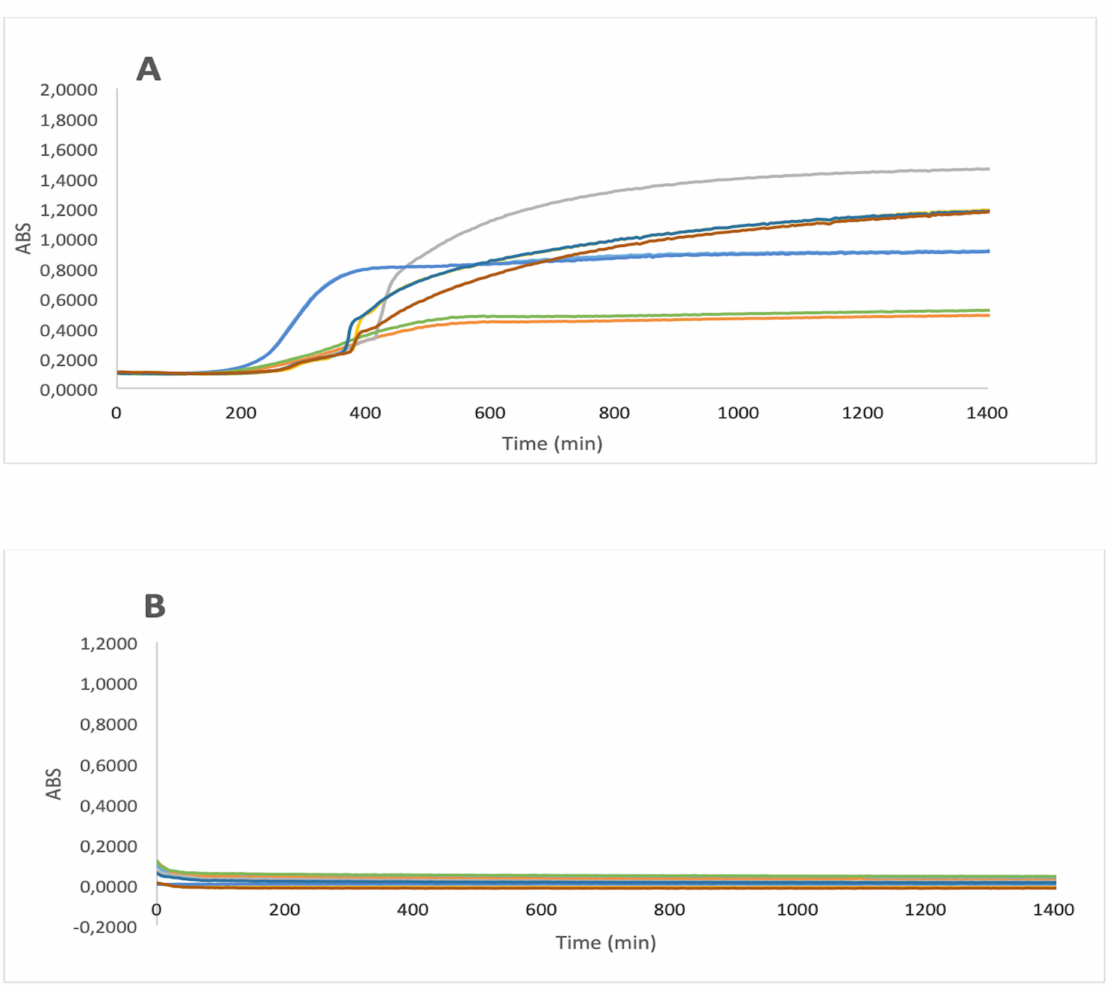
Figure 1. Bacterial growth of Staphylococcus aureus ATCC 29,213 ( — ), S. aureus 393 ( — ), Pseudomonas aeruginosa L2 ( — ), P. aeruginosa L4 ( — ) in the absence ( A ) and presence ( B ) of Iron Animals. ABS (arbitrary units) = optical density OD 600 − blank OD 600